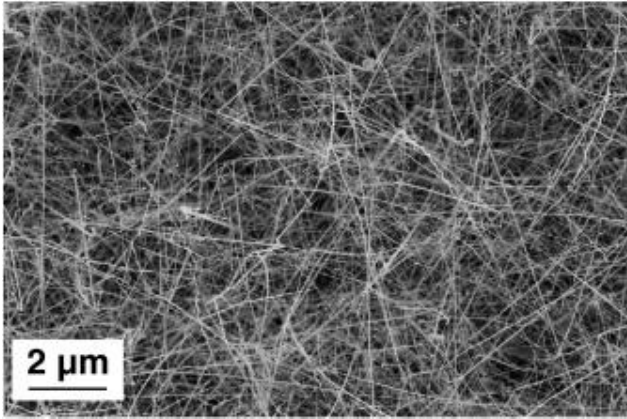
Figure 3. Secondary-electrons (SE) SEM image of tin oxide nanowires. Reproduced with permission Figure 3. ( a ) Secondary-electrons (SE) SEM image of tin oxide nanowires. Reproduced with from permission from [35].